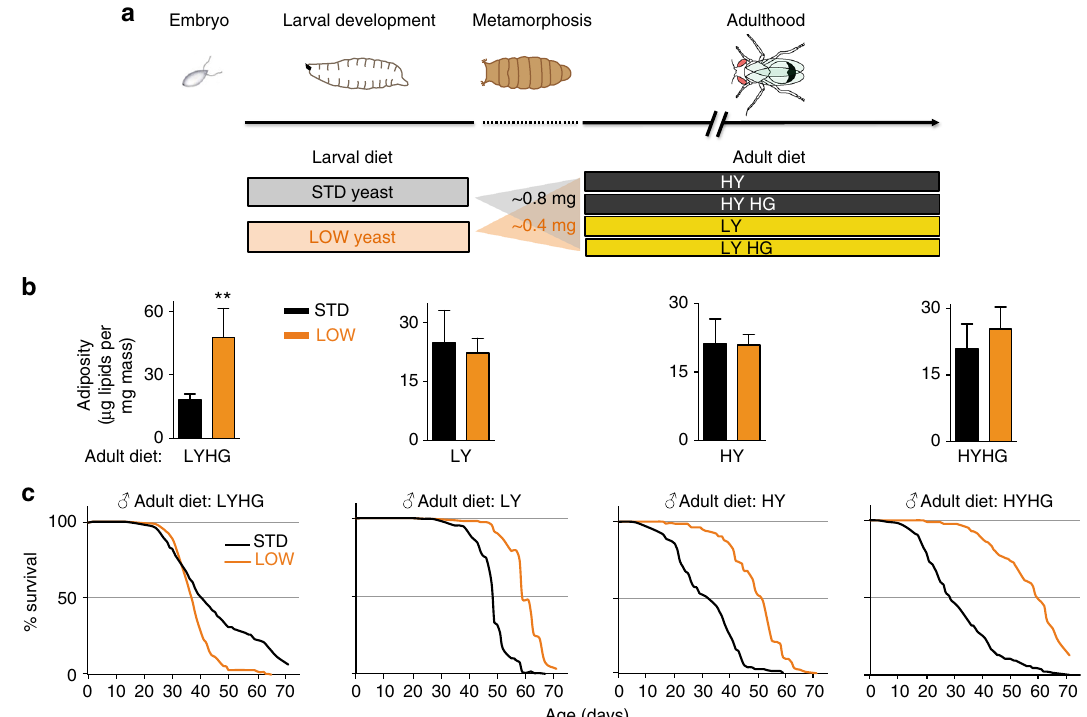
Fig. 1 Developmental dietary history alters adult physiology and lifespan. a The eight larval-adult dietary combinations used in this study. b LOW larval diet increases male adiposity (triglycerides + cholesteryl esters per mg body mass) at 2 weeks post-eclosion on the LYHG adult diet but not on the other three adult diets (in all cases, n = 4). ** p < 0.01, two-tailed t -test. c LOW (orange) males survive longer than STD (black) males on three of the four adult diets tested (30 fl ies per vial). See text for details of adult diets. In this and subsequent fi gures, error bars show 1 s.d. n numbers and the statistical analysis of all survival curves is provided in Supplementary Data